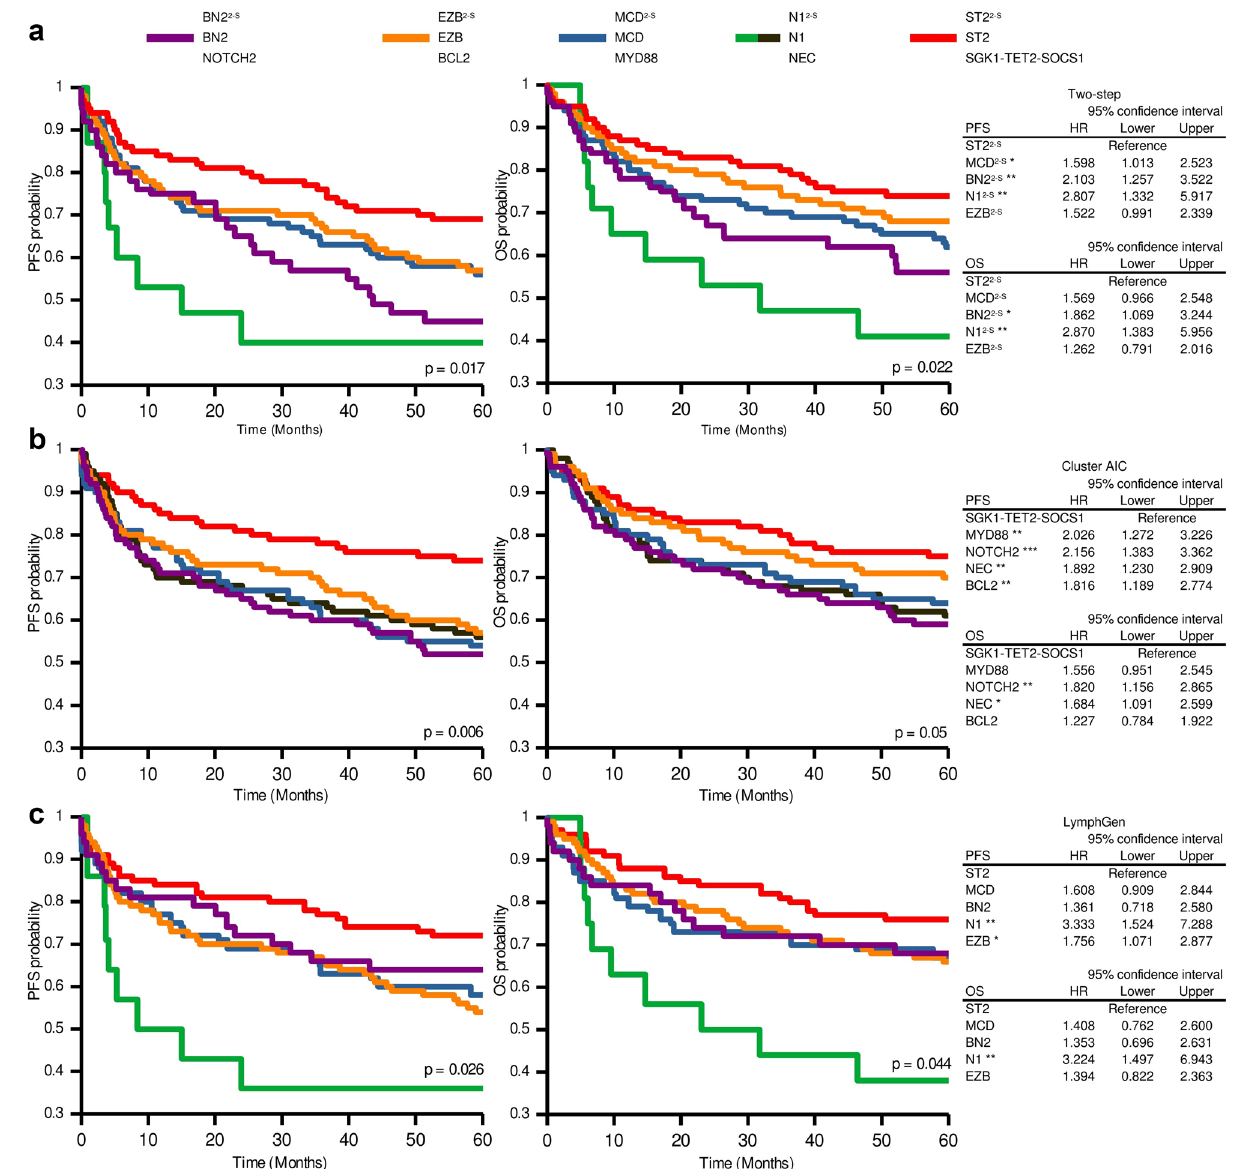
Figure 5. Progression-free survival (PFS) and overall survival (OS) according to the genetic subtypes of the two-step, AIC cluster and LymphGen classifiers in the HMRN cohort. Kaplan–Meier analysis of genetic subtypes from ( A ) two-step, ( B ) AIC cluster and ( C ) LymphGen methods. Tables on the right of the figure show the hazard ratio (HR) values from the Cox proportional-hazards model of genetic subtypes for PFS and OS status. Error bars represent the 95% confidence intervals. Significance: *p < 0.05; **p <